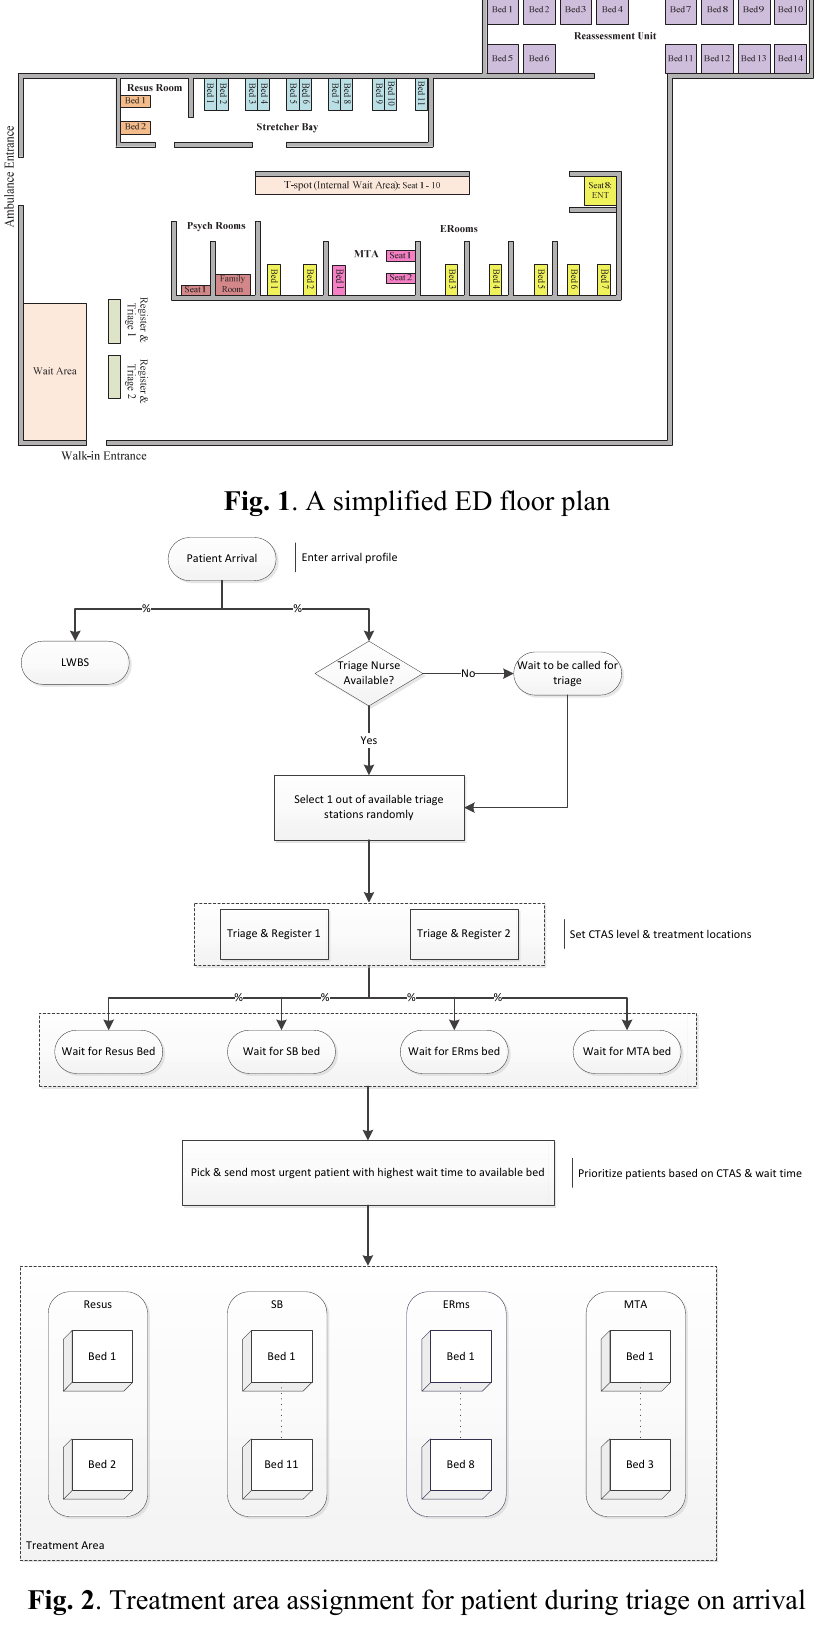
Fig. 2 . Treatment area assignment for patient during triage on